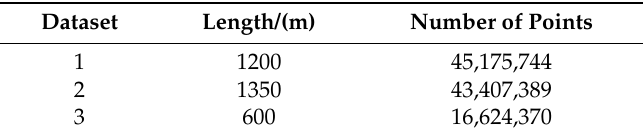
Figure 12. An overview of the experimental data. Table 1. Description of the datasets.